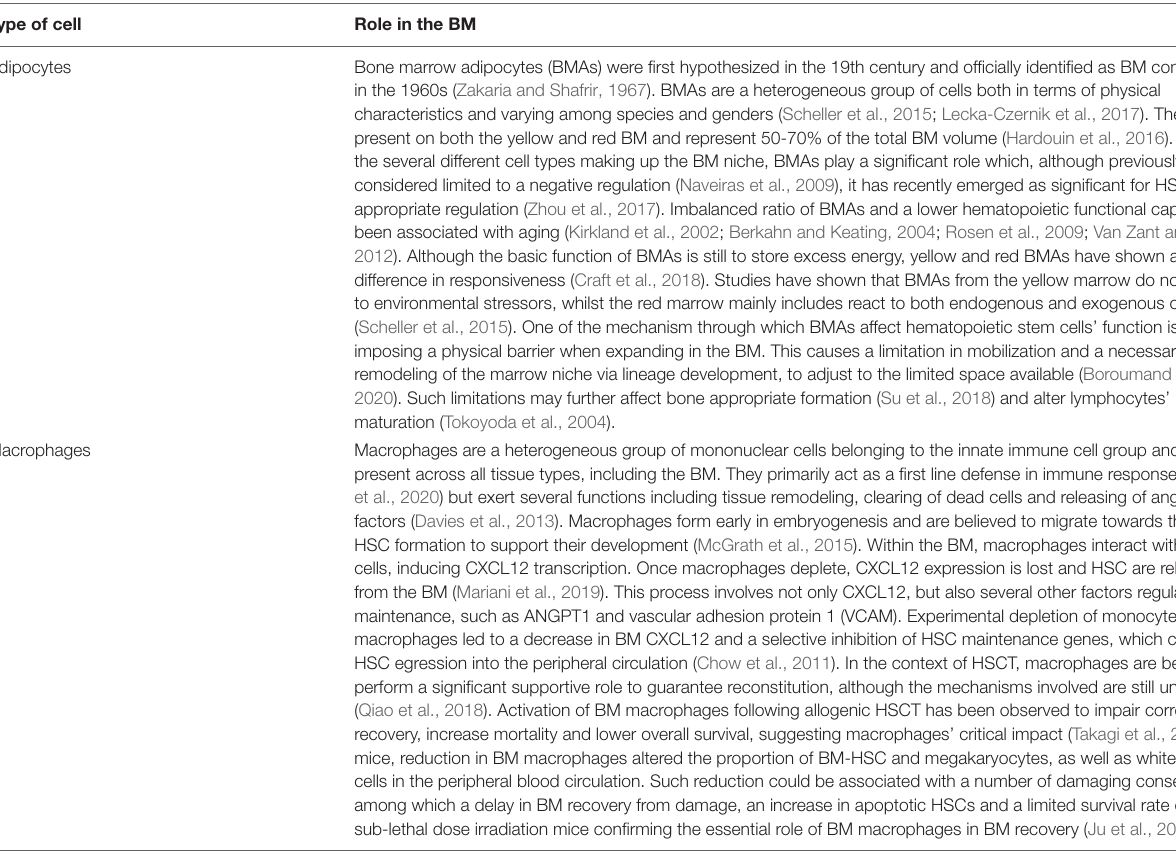
Table summarizing the non-hematopoietic components of the human BM